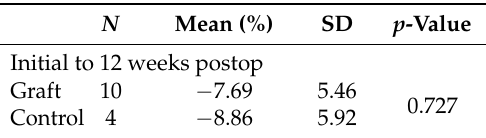
Table 2. Evaluation of percentage change of ridge width from initial to 12 weeks postoperative for experimental and control